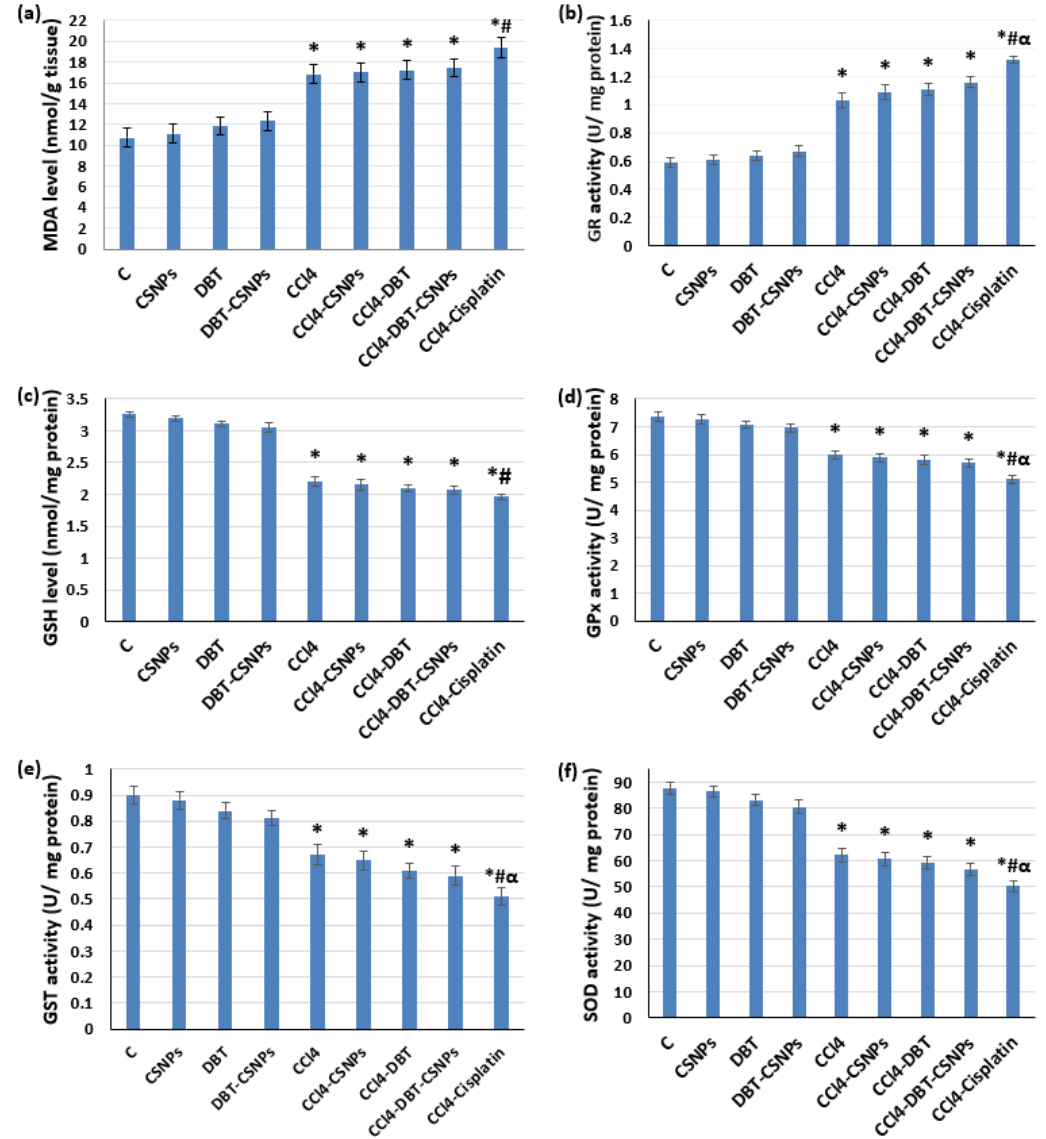
Figure 2. Effect of different studied compounds on OS parameters. ( a ) malondialdehyde (MDA), ( b ) glutathione re- ductase (GR), ( c ) reduced glutathione (GSH), ( d ) glutathione peroxidase (GPx), ( e ) glutathione-S-transferase (GST), and ( f ) superoxide dismutase (SOD) activities. The values represent the mean ± SD of eight rats. One-way ANOVA was used (* p < 0.05 versus saline control group, # p < 0.05 versus CCl 4 group & α p < 0.05 versus DBT–CSNP-treated group).